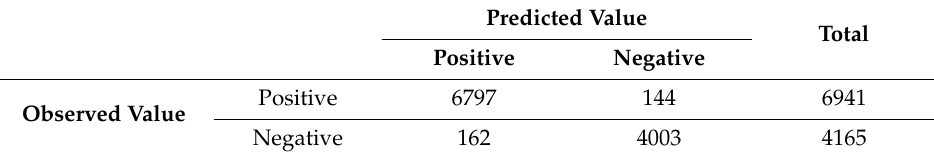
Table 5. The confusion matrix of the double-branch discrimination